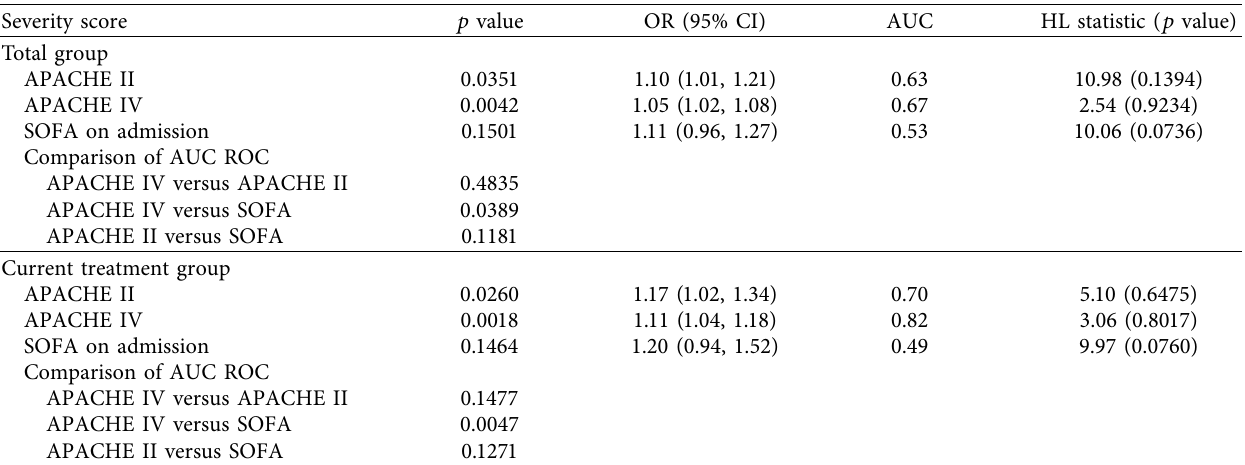
Table 3: Results of the univariate logistic regression